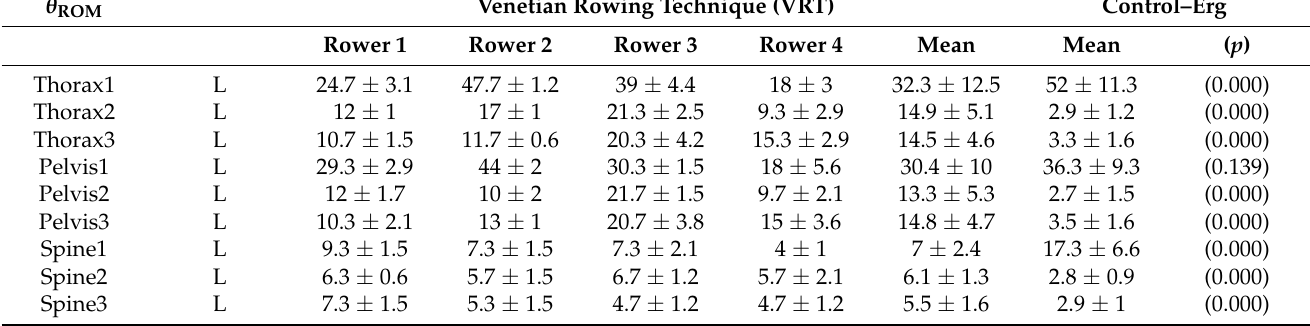
Table 1. The range of motion values, θ ROM , of the thorax, pelvis and spine angles measured for the Venetian style rowing technique, in degrees, ± 1 s.d., for the individual rowers 1–4, their mean, and its equivalent mean value for standard ergometer rowing, with p -value for these two means reported in parentheses.